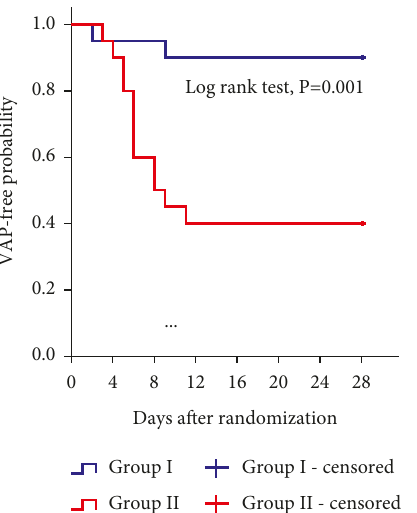
Figure 2: Kaplan–Meier plot estimates of the risk of ventilator- associated pneumonia (VAP) occurring in 28 days between the study groups.